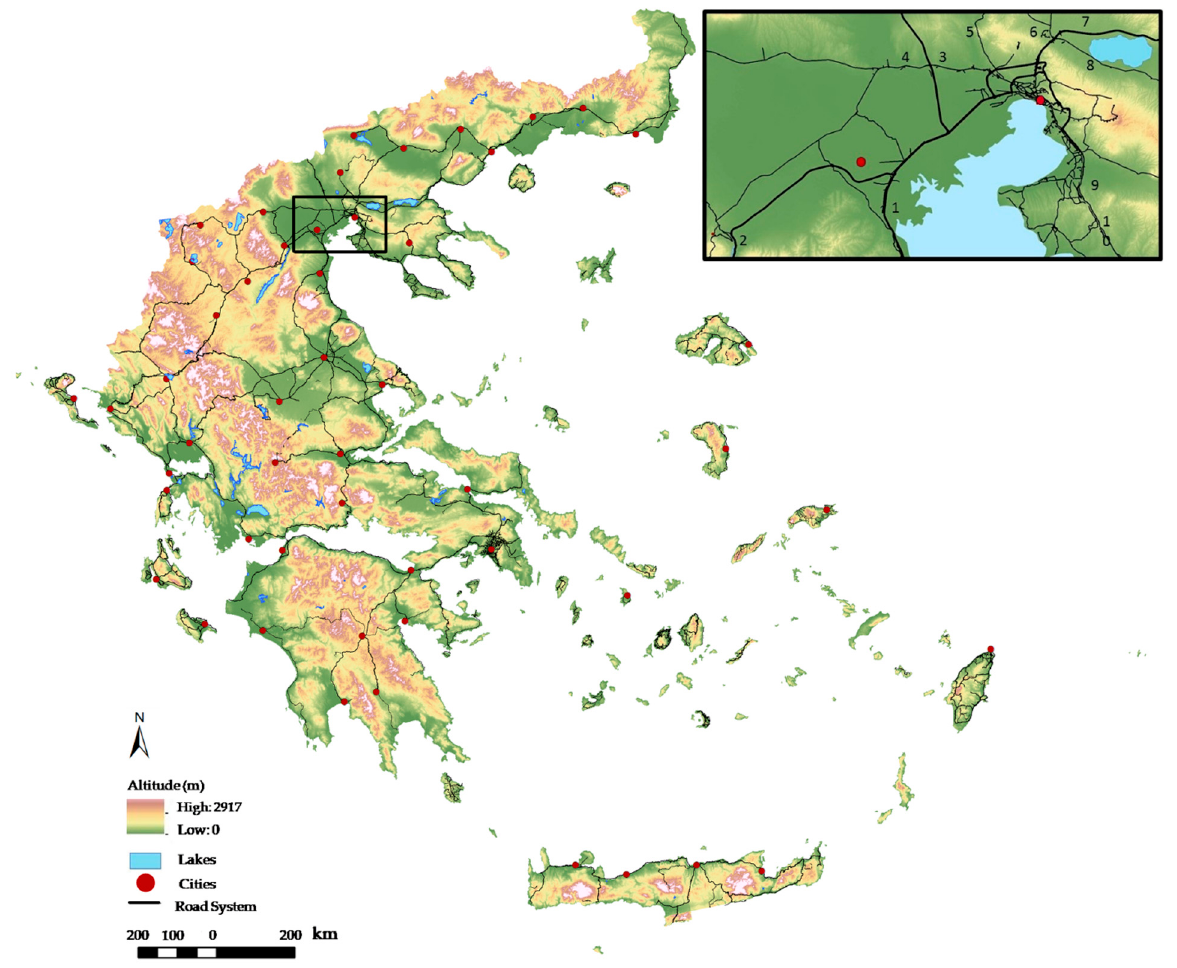
Figure 6. Geomorphology of the Greek territory with the basic road network connecting the capitals of local prefectures and overview of the inventories performed for Solanum elaeagnifolium (black lines). The zoomed-in area indicates an example of individual inventories performed from one city (Thessaloniki, Northern Greece) to other destinations such as exit roads to: Athens (1), Igoumenitsa (2), Edessa (3), Evzoni (4), Kilkis (5), Serres (6), Alexandroupoli (7), Kavala (8), northern Chalkidiki (9) and southern Chalkidiki (10).